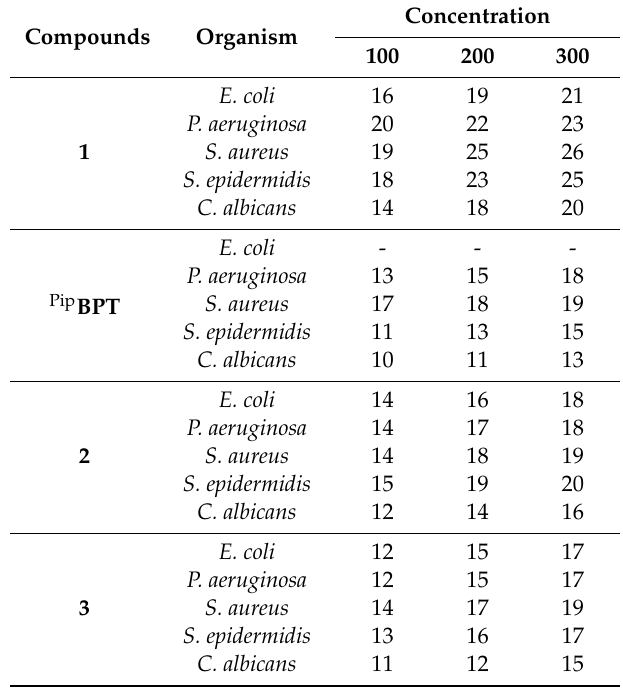
Table 7. Minimum inhibitory concentrations (MIC) ( µ g / mL) and minimum bactericidal concentrations (MBC) ( µ g / mL) of 1 – 3 against the growth of target microbes.